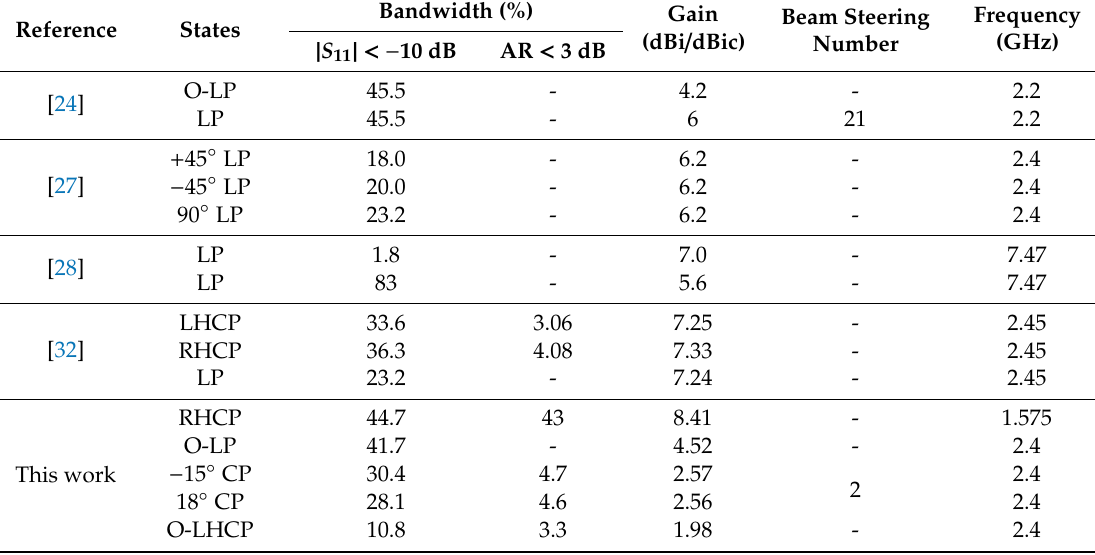
Table 5. Performance comparison of the state-of-the-art reconfigurable liquid metal antennas.